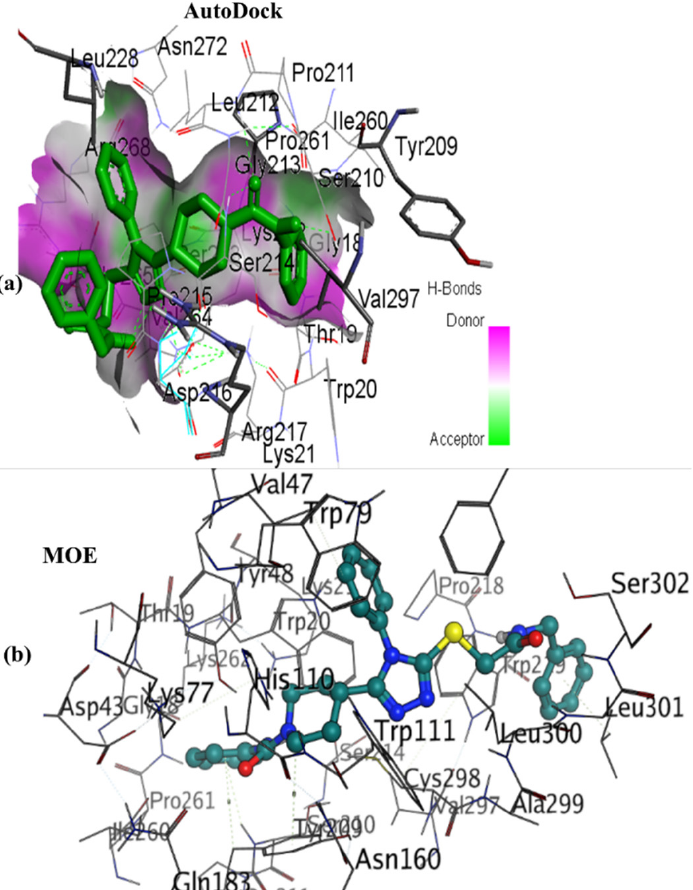
Figure 4. The docking conformations of most potent compounds of target AKR1B1. ( a ) Compound 7d in pocket of AKR1B1 (visualization by AutoDock), ( b ) Compound 7d in pocket of AKR1B1 (visualization by MOE).